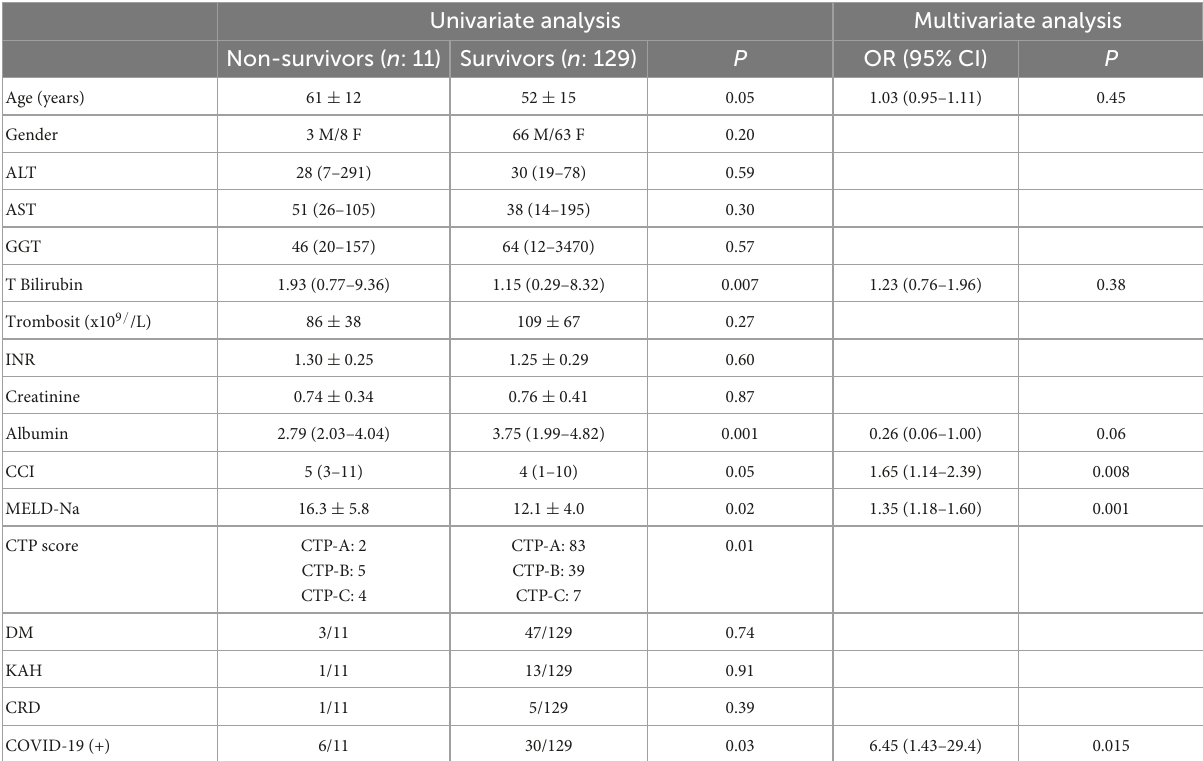
TABLE 3 Comparison of the characteristics of cirrhosis patients with and without death. Univariate analysis Multivariate